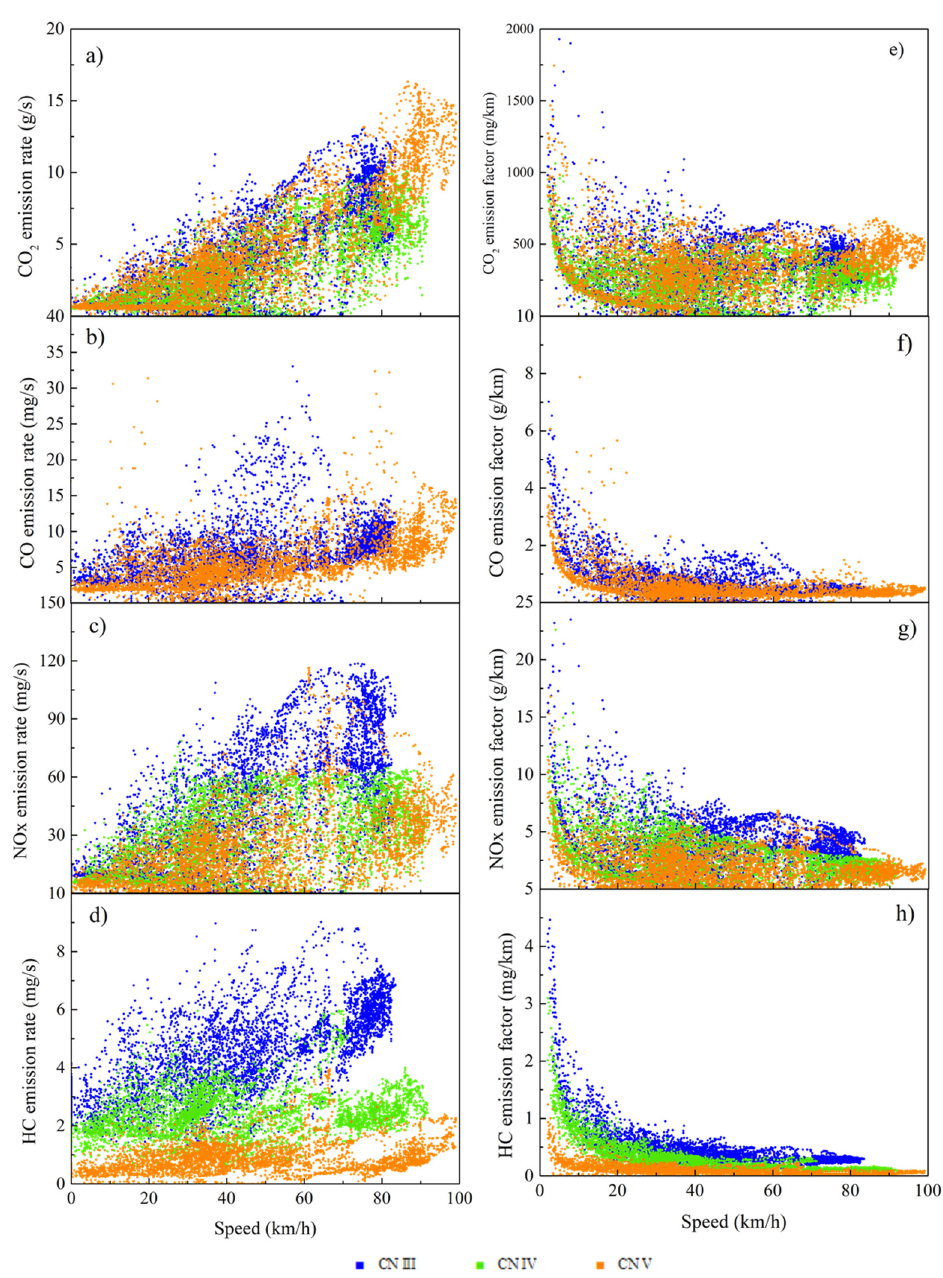
Figure 4. Data of LDDTs complying with China III, China IV, and China V emission standards. Instantaneous EFs ( a – d ) and emission factors ( e – h ) of CO, HC and NO at various speeds.